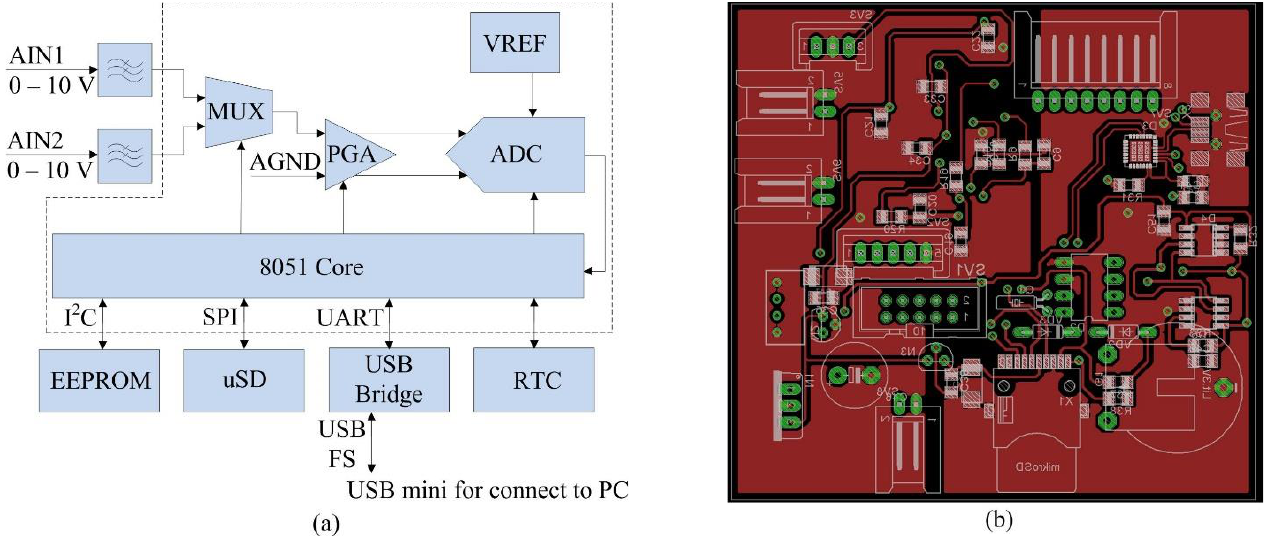
Figure 9. Datalogger: ( a ) Simplified scheme; ( b ) Printed circuit board.